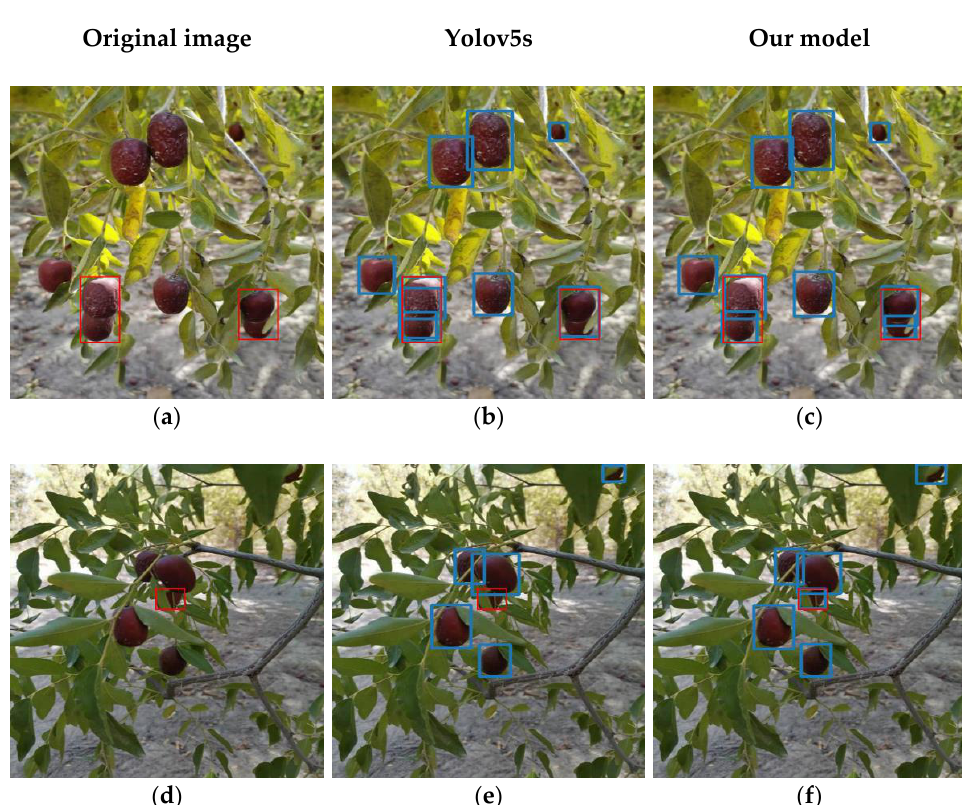
Figure 11. The results of different algorithms for the recognition of red jujube. ( a ) the original image of a dense jujube sample. ( b ) the original model to dense jujube detection image. ( c ) the improved model to dense jujube detection image. ( d ) the original image of leaf-obscured jujube. ( e ) the original model to leaf-obscured jujube detection image. ( f ) the improved model to leaf-obscured jujube detection image. Where the red boxes are the label boxes marked manually, and the blue boxes are the test results of model test.